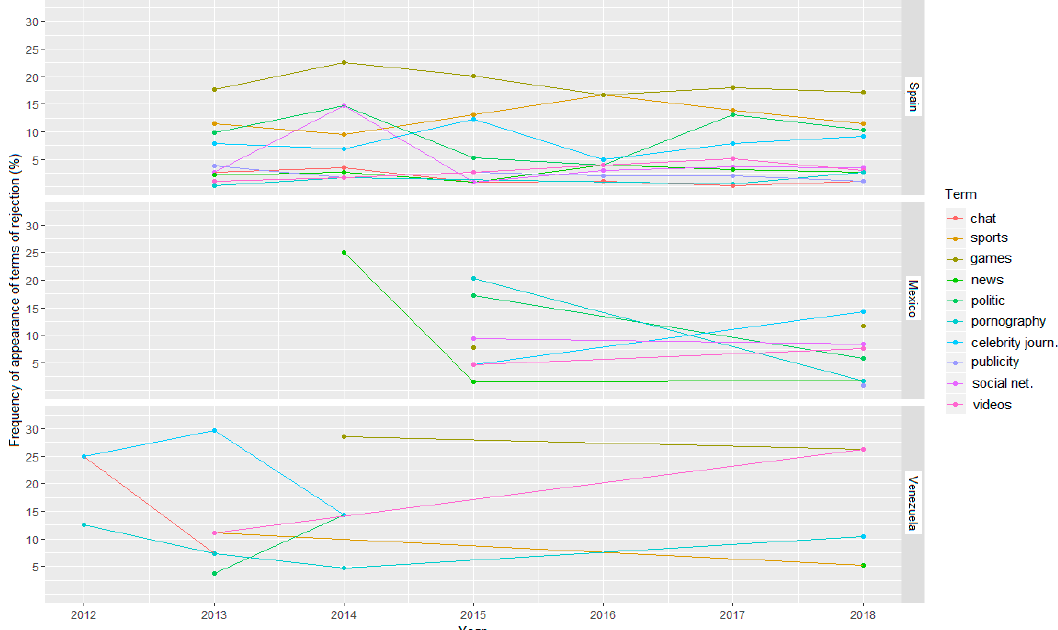
Figure 6. Temporal variation of the 10 most common terms named by respondents as topics of rejection for web surfing (comparison of three selected countries).